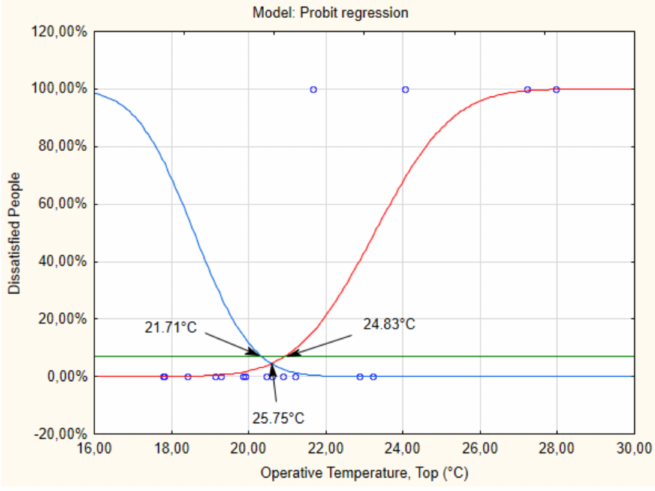
Figure 11. Probit APD_2. According to the suggested cutoff of 6.98%, the thermal comfort zone is 20.71 ◦ C to 20.93 ◦ C with a neutral operative temperature of 20.75 ◦ C, where 5.28% of people would be dissatisfied. Figure 12 shows the model’s result for APD_3.